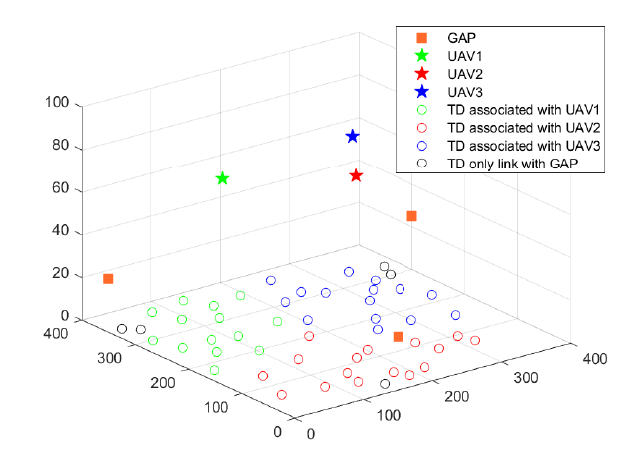
TDs and UAVs. The vertical location of UAVs are 70.1 m, 79.5 m, 73 m, respectively. They all keep in medium rather than maximum or minimum height. That is because, for the probabilistic LoS channel, a low fly height will cause a small probability of LoS state. However, the high fly height will cause a serious path loss. Thus, the medium height finally achieves a better offloading link.